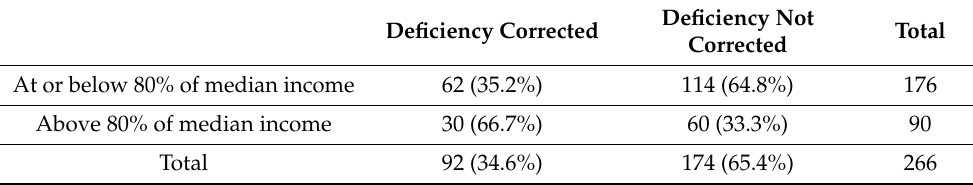
Table 2. Number of housing deficiencies resolved by 80% of median